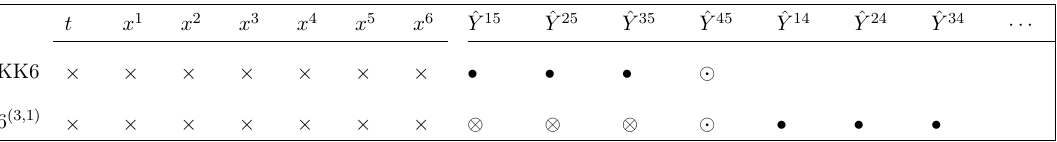
Table 5 . Embedding of the KK6 monopole and the 6 (3 ; 1) -brane obtained by the rotation U 123 . Bullets denote the directions on which the harmonic function depends, (cid:2) denote the worldvolume directions and (cid:10) denote smeared directions. The quadratic special circle (cid:12) for the 6 (3 ; 1) -brane is along the same direction as for the KK-monopole. Three cubic directions then correspond to the three non-geometric coordinates in the harmonic